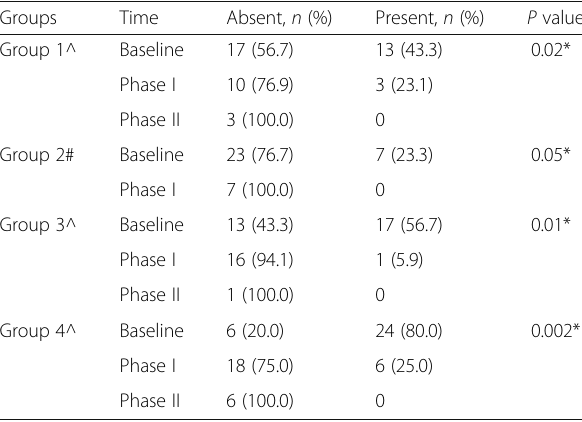
Table 5 Comparison of microbial presence between the baseline and different phases of decontamination